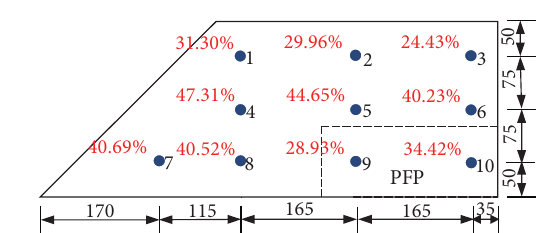
Figure 4: Weight percentages of the fine particles at the obser- vation points (length unit: